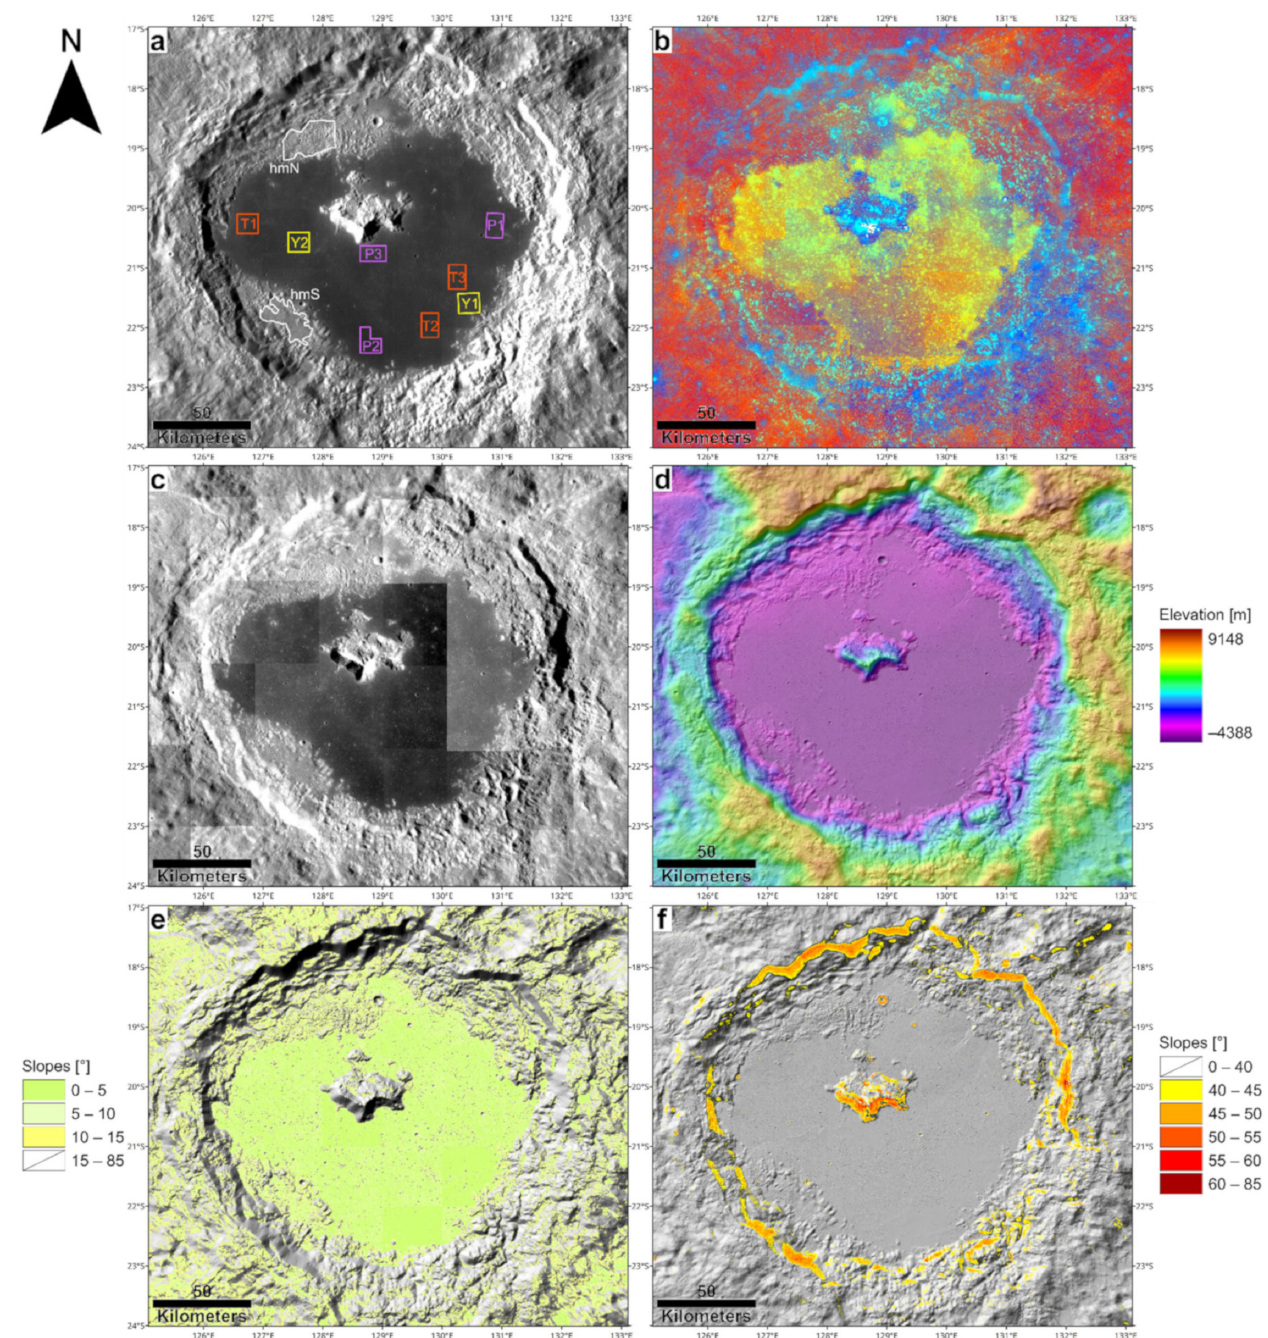
Figure 2. The lunar far side Tsiolkovskiy crater in equirectangular projection. ( a ) Lunar Reconnaissance Orbiter Wide Angle Camera mosaic (~100 m/pixel) [30] with boxes delimiting the crater size–frequency distribution measurements areas; ( b ) Clementine UVVIS Warped Color Ratio mosaic (~200 m/pixel) [19]; ( c ) Kaguya Terrain Camera mosaic (~10 m/pixel) [31]; ( d ) Lunar Orbiter Laser Altimeter and Kaguya Terrain Camera DEM merge (~59 m/pixel and 3–4 m) [33] on top of the hillshade DEM-derived basemap; ( e ) surface slope map for slopes < 15 ◦ on top of the hillshade DEM-derived basemap; and ( f ) surface slope map for slopes > 40 ◦ on top of the hillshade DEM-derived basemap. The color-based spectral mapping was produced using the ~200 m/pixel Clementine UVVIS Warped Color Ratio mosaic (Red: 750/415 nm; Green: 750/1000 nm; and Blue: 415/750 nm, Figure 2b). According to [19], red colors are ascribable to low titanium or high glass contents, and thus also to pyroclastic deposits. High iron contents